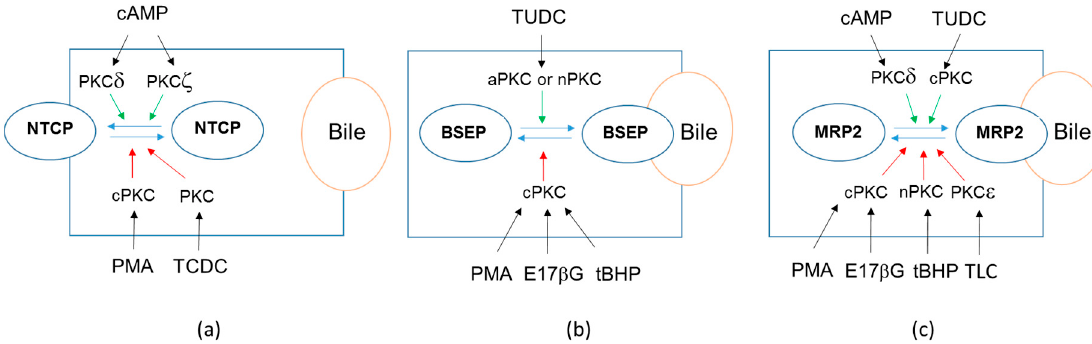
Figure 3. Schematic representation of protein kinase C (PKC) effects on trafficking of ( a ) sodium-taurocholate co-transporting polypeptide (NTCP), ( b ) bile salt export pump (BSEP) and ( c ) multidrug resistance-associated protein (MRP) 2 in hepatocytes. Black arrows indicate activation of PKCs by compounds. Red arrows indicate stimulation of transporter internalization by PKCs. Green arrows show stimulation of membrane insertion of transporters by PKCs. Blue arrows correspond to trafficking (internalization/membrane insertion) of transporters. PMA: phorbol-12-myristate-13-acetate; TCDC: taurochenodeoxycholate; E17 β G: estradiol 17 β - D -glucuronide; tBHP: tertio-butylhydroperoxide; TLC: taurolithocholate; cAMP: 3 ′ ,5 ′ -cyclic adenosine monophosphate; TUDC: tauroursodeoxycholate